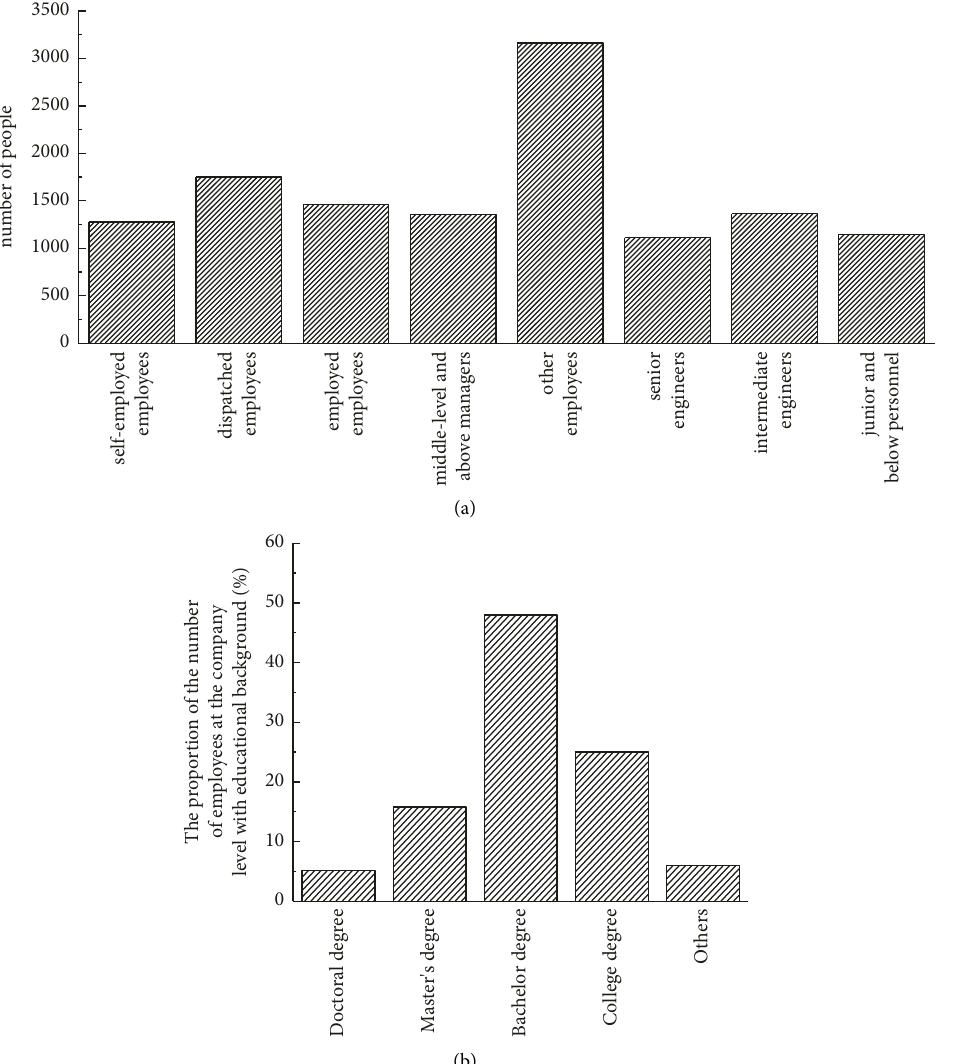
Figure 3: The proportion of employees at each level of Company A. (a) The number of company personnel. (b) The proportion of the number of employees at the company level with educational